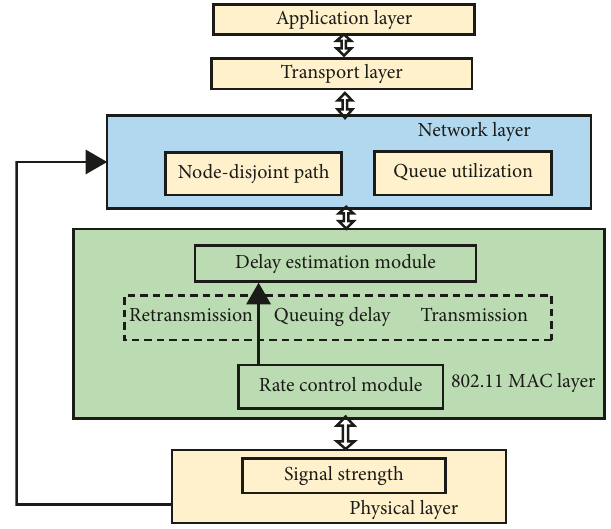
Figure 1: Cross-layer architecture design proposed in CADM.